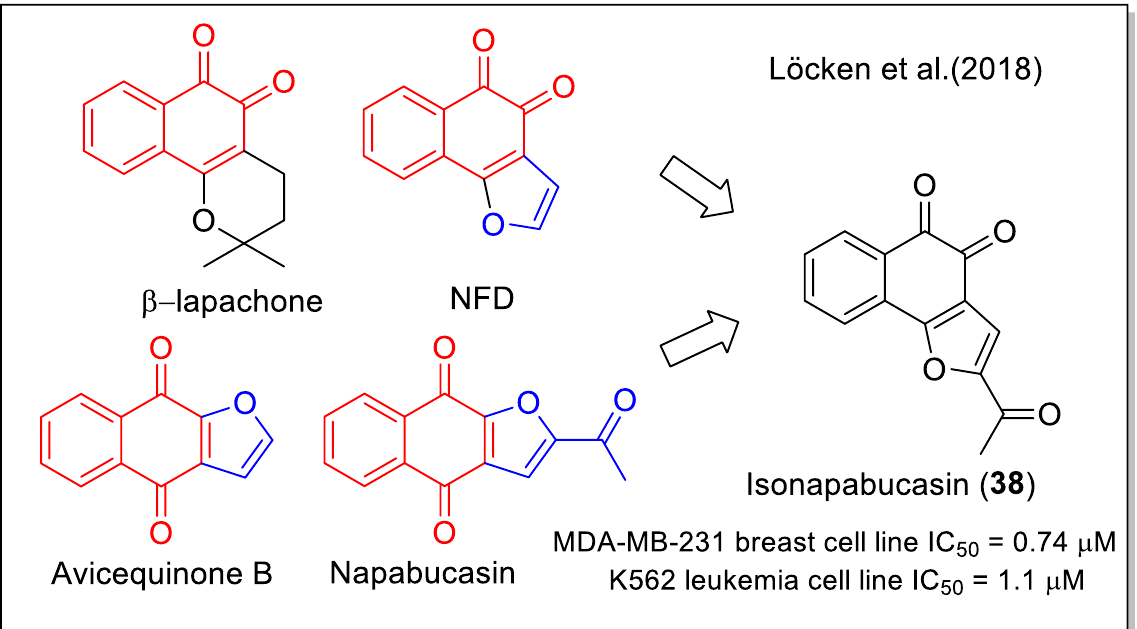
Figure 17. The 1,2-naphthoquinone-2-acetyl furane hybrid as reported by Löcken et al. [52].